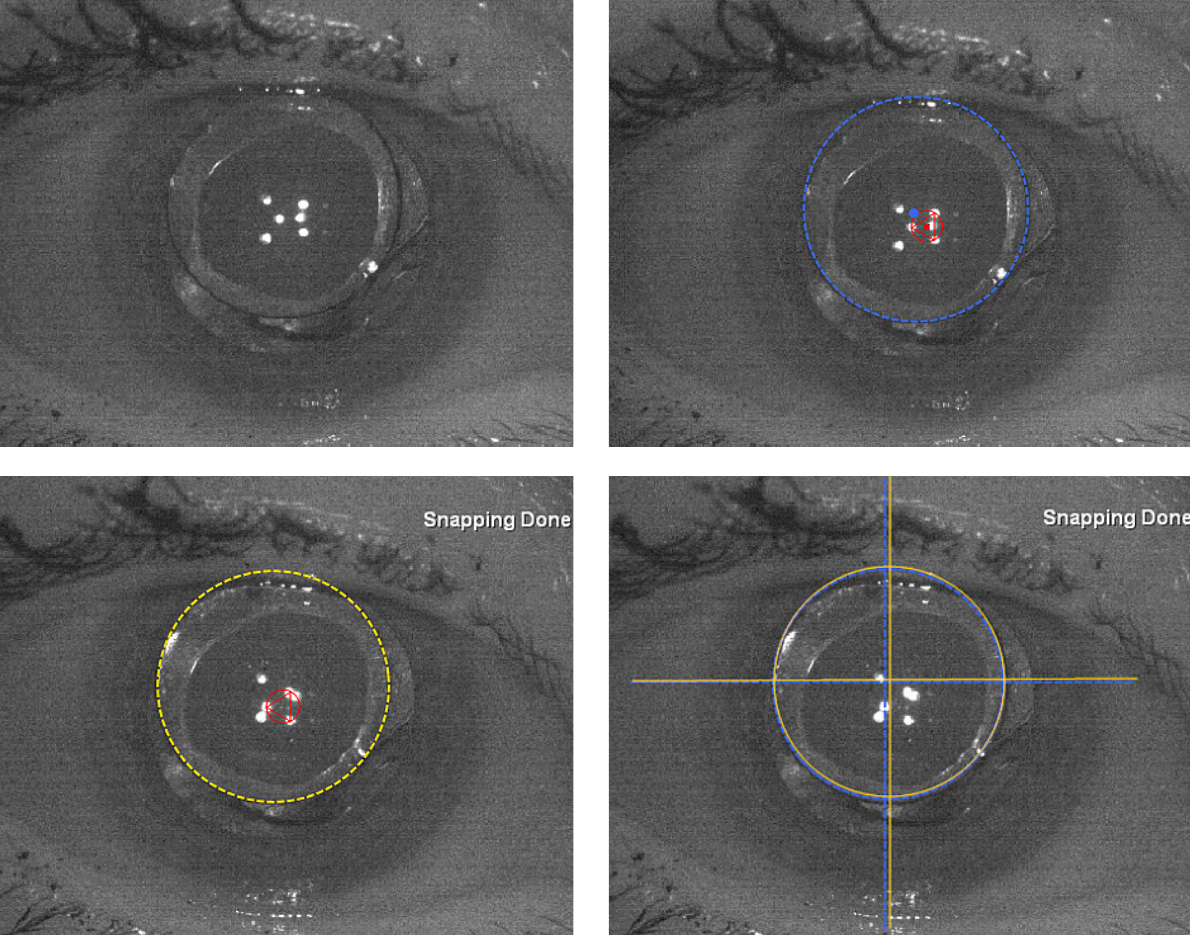
Fig. 2. Infrared images for evaluation of IOL decentration. a. default image. b. reference point (red) and contours of the optical part of IOL with center point (blue) before capsulotomy. c. contour of the optical part of IOL with center point (yellow) after capsulotomy. d. blending of both contours and visualization of change in